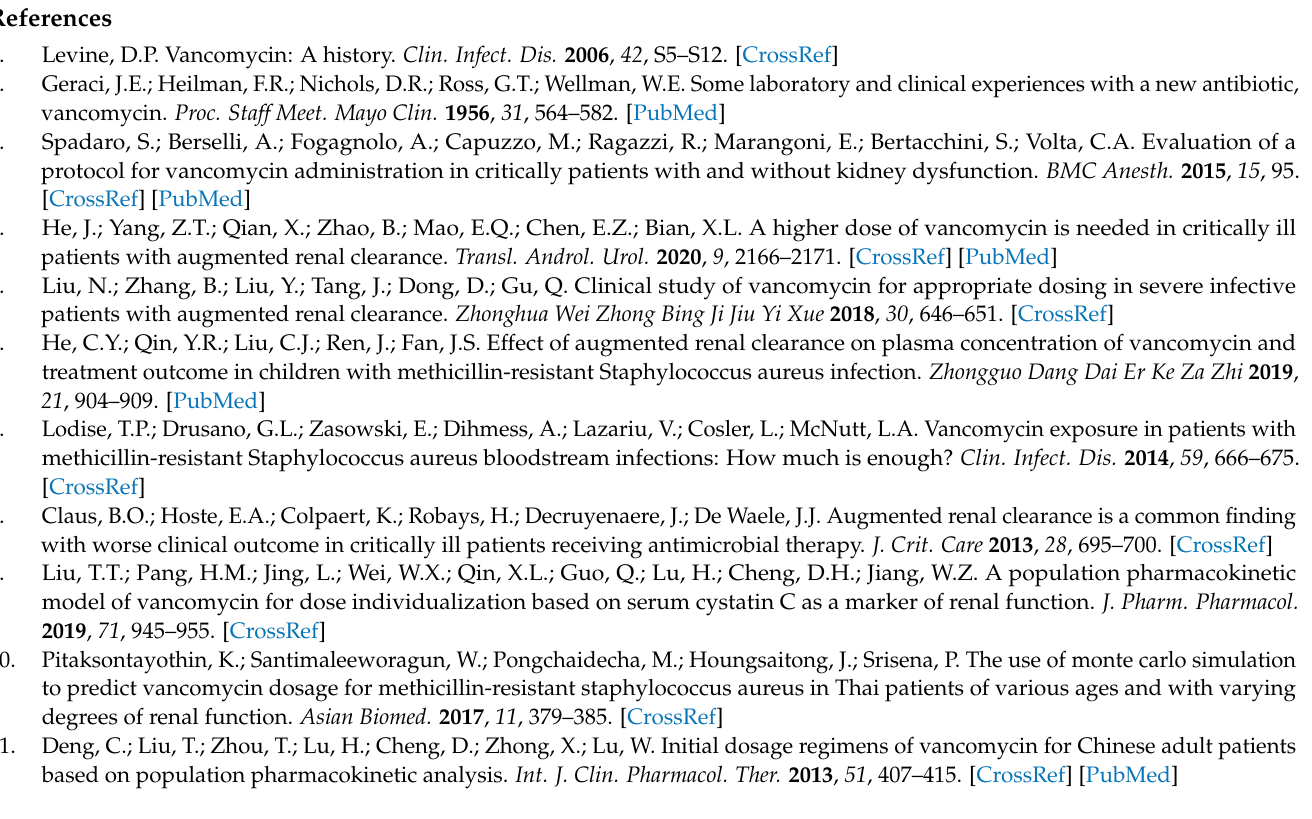
Figure S2. Distribution of AUC 24 at recommended vancomycin regimens., Figure S3. Scatter diagram format with creatinine clearance calculated by the Cockcroft–Gault equation (CG) and the drug clear- ance (Clearance)., Table S1: Recommended initial dosage regimens for targeted trough concentration of 10–20 mg/L